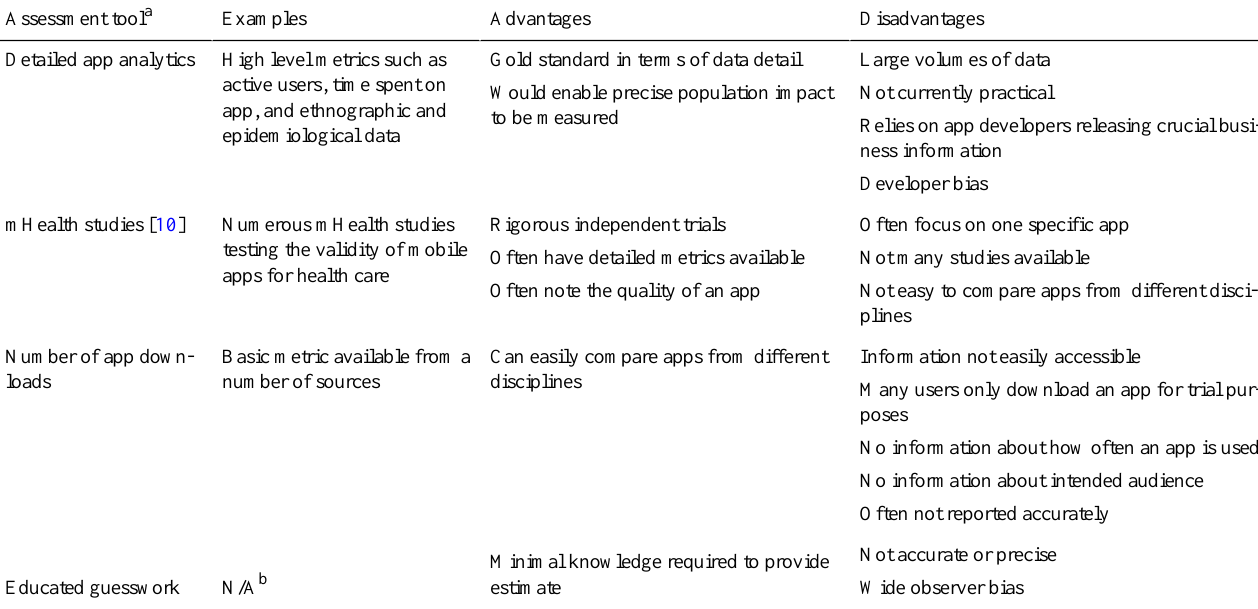
Table 1. Models currently in use for assessing the impact of a mobile app on a given population. DisadvantagesAdvantagesExamplesAssessment tool